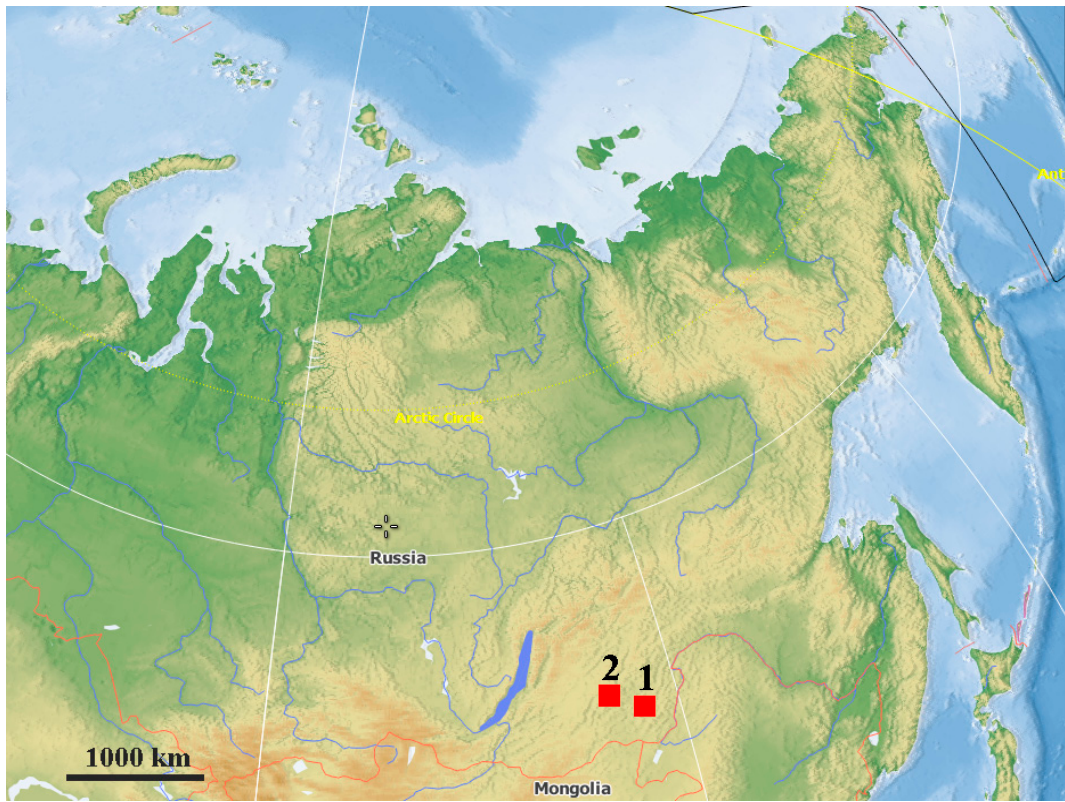
Figure 1. Map of north eastern Eurasia with geographic position of the two study sites: 1—Urtuy; 2—Nozhiy. The base maps are from the public domain atlas in the desktop app, Marble 2.2.20 ( http://edu.kde.org/marble ).